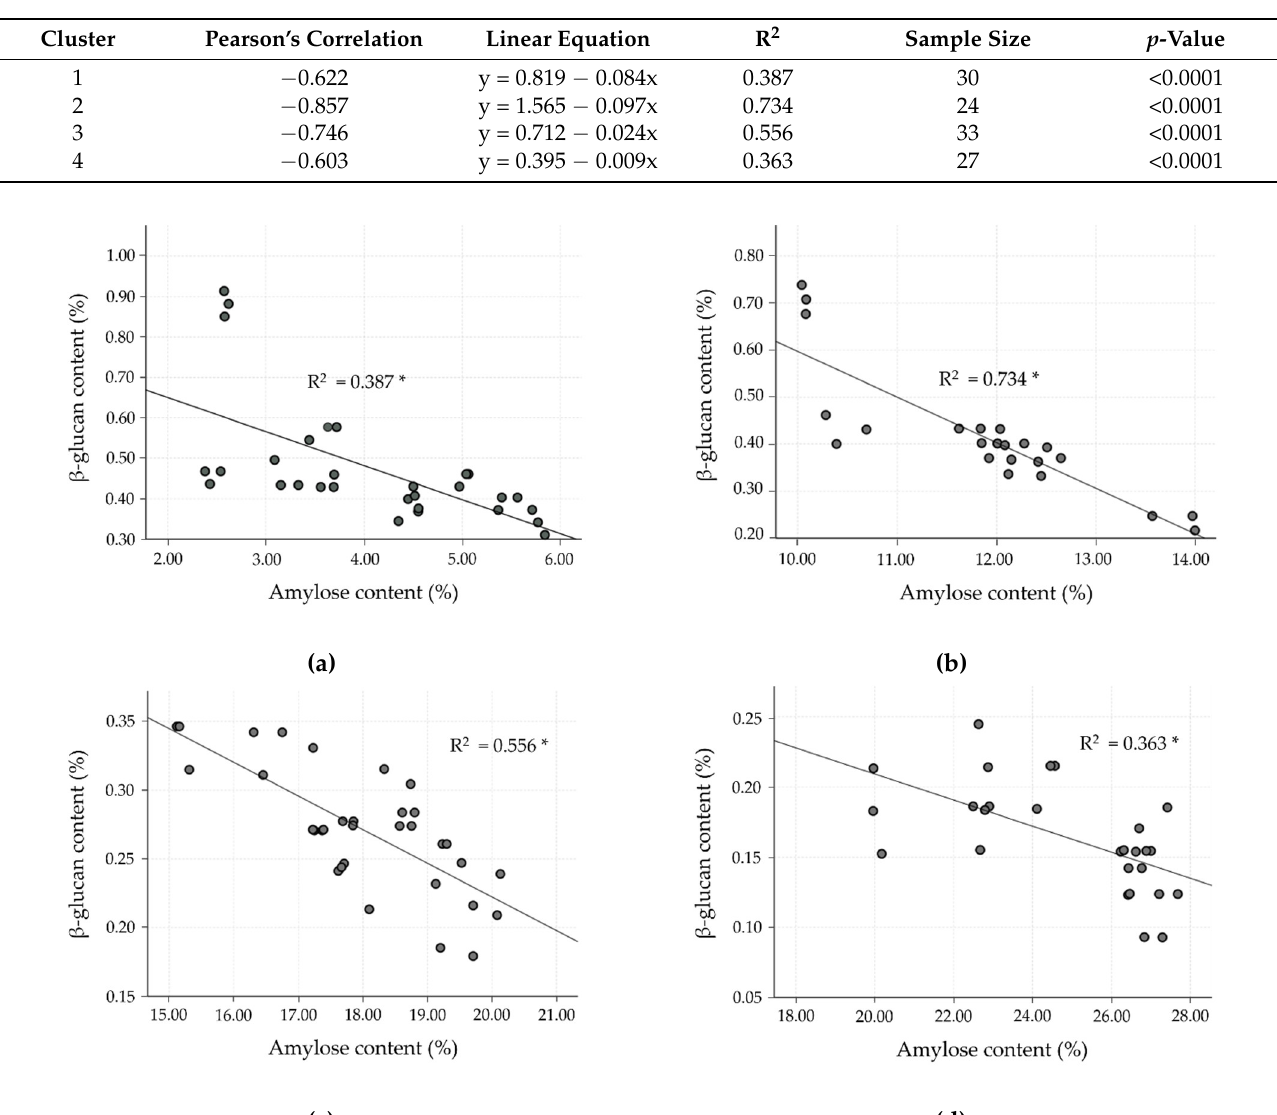
Table 5. Pearson’s correlation coefficients, linear equation, R 2 , sample sizes, and p -value for amylose and β-glucan contents in milled rice fraction.